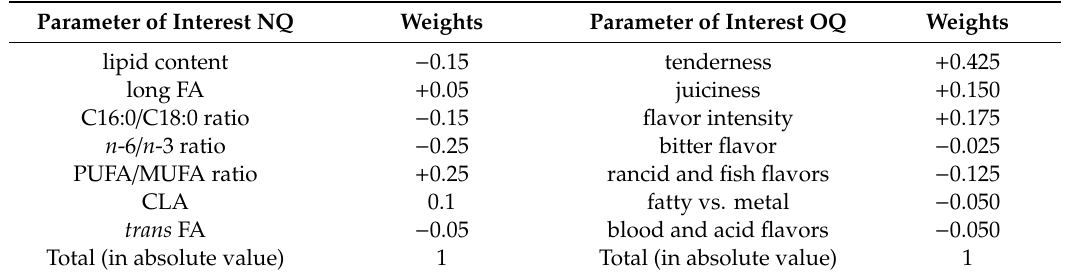
Table 1. Importance weights related to each variable evaluating the nutritional and organoleptic qualities. Parameter of Interest NQ Weights Parameter of Interest OQ Weights lipid content − 0.15 tenderness + 0.425 long FA + 0.05 juiciness + 0.150 C16:0 / C18:0 ratio − 0.15 flavor intensity + 0.175 n -6 / n -3 ratio − 0.25 bitter flavor − 0.025 PUFA / MUFA ratio + 0.25 rancid and fish flavors − 0.125 CLA 0.1 fatty vs. metal − 0.050 trans FA − 0.05 blood and acid flavors − 0.050 Total (in absolute value) 1 Total (in absolute value)